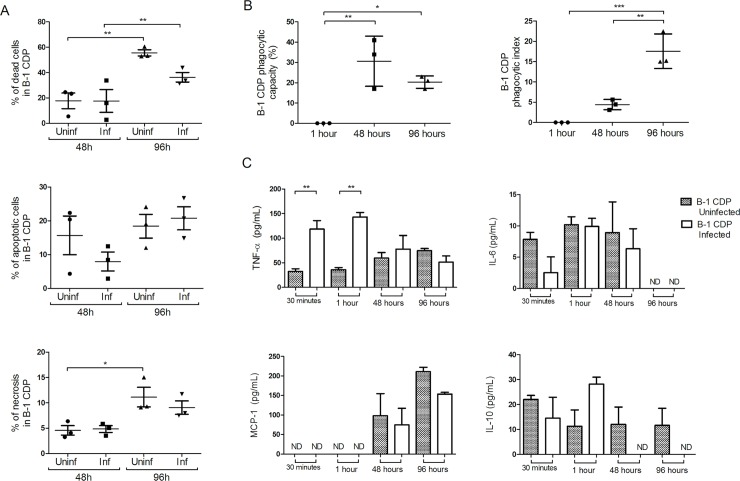
Necrosis and apoptosis, phagocytic activity and cytokines levels in the supernatants from B-1 CDP cultures.(A) Percentual of death cells, apoptotic cells and necrotic cells in B-1 CDP culture at 48 and 96 h. (B) Phagocytic capacity and phagocytic index in B-1 CDP culture infected with E. cuniculi after 1, 48, and 96 h. (C) Cytokines levels after 1, 48, and 96 h post infection with E. cuniculi. The data are presented as mean ± SEM (*P < 0.05, ** P < 0.01, *** P <0.001, One way ANOVA with Tukey post-test, ND = not detected).